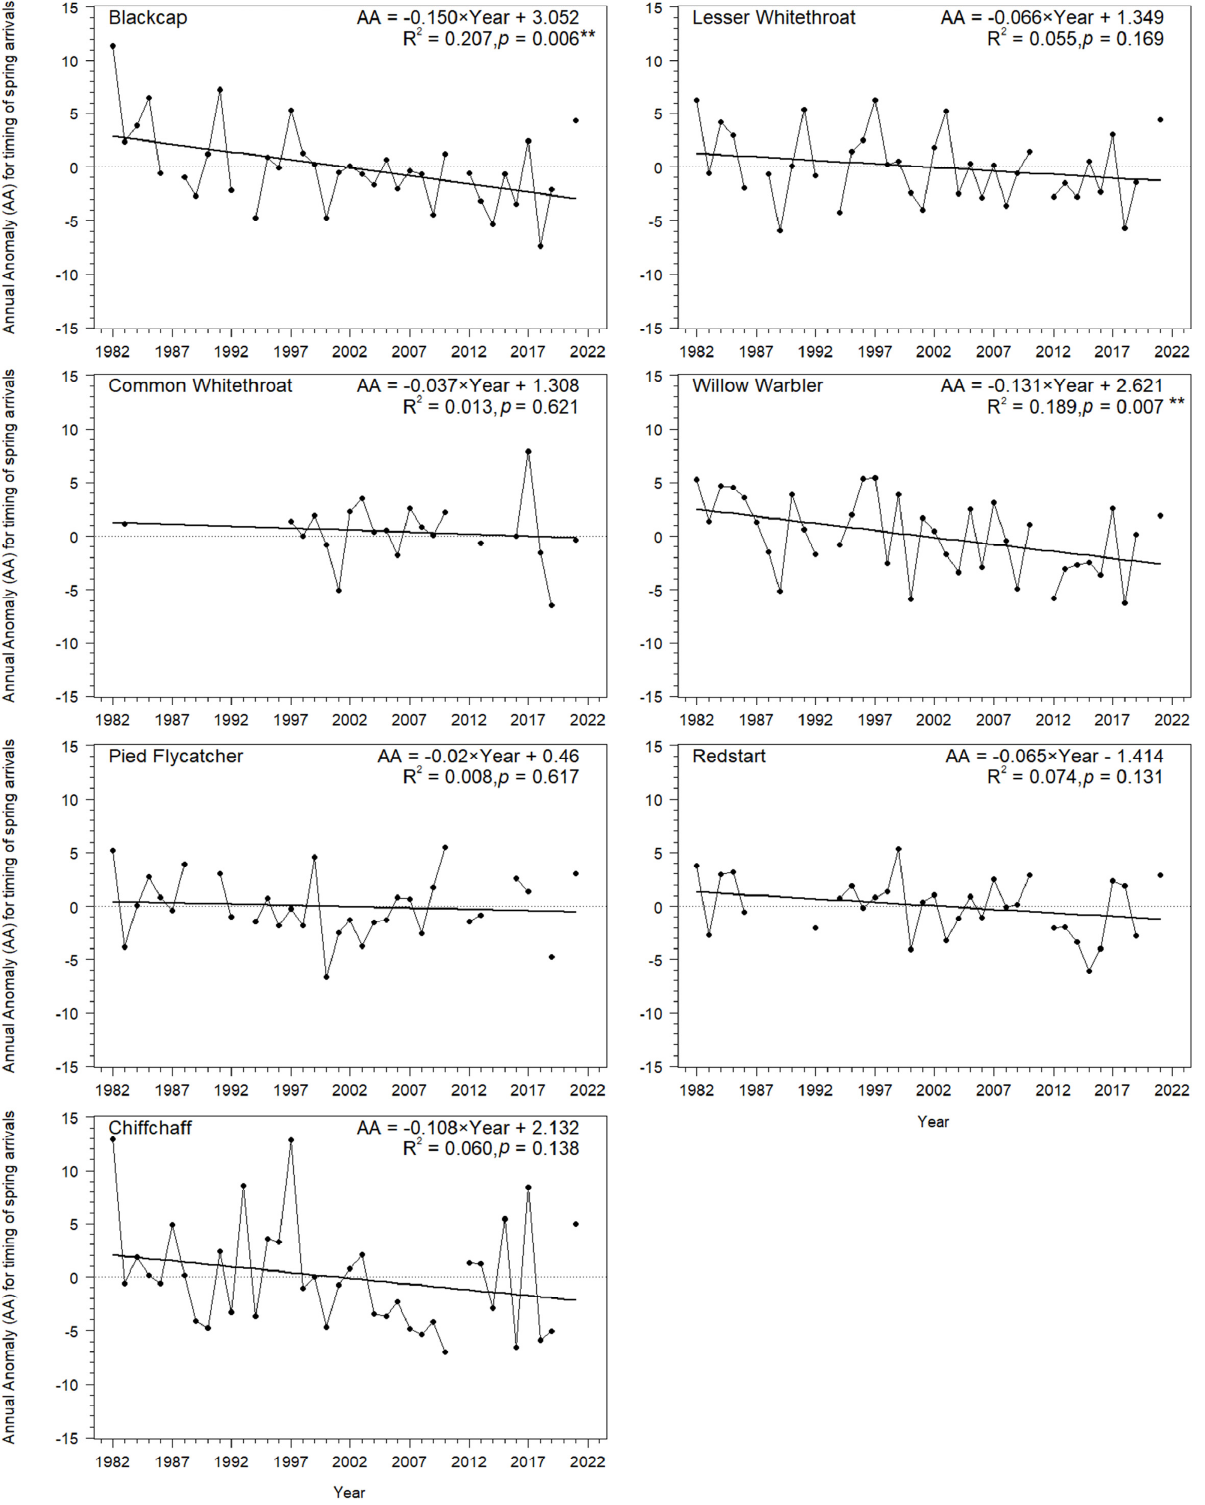
Figure 6. Trends for the Annual Anomaly (AA) of spring migration of the seven long-distance migrants at Bukowo, Poland, over 1982–2021. Year is used in the equations as the explanatory variable. Statistical significance of the regression equations: ** p <